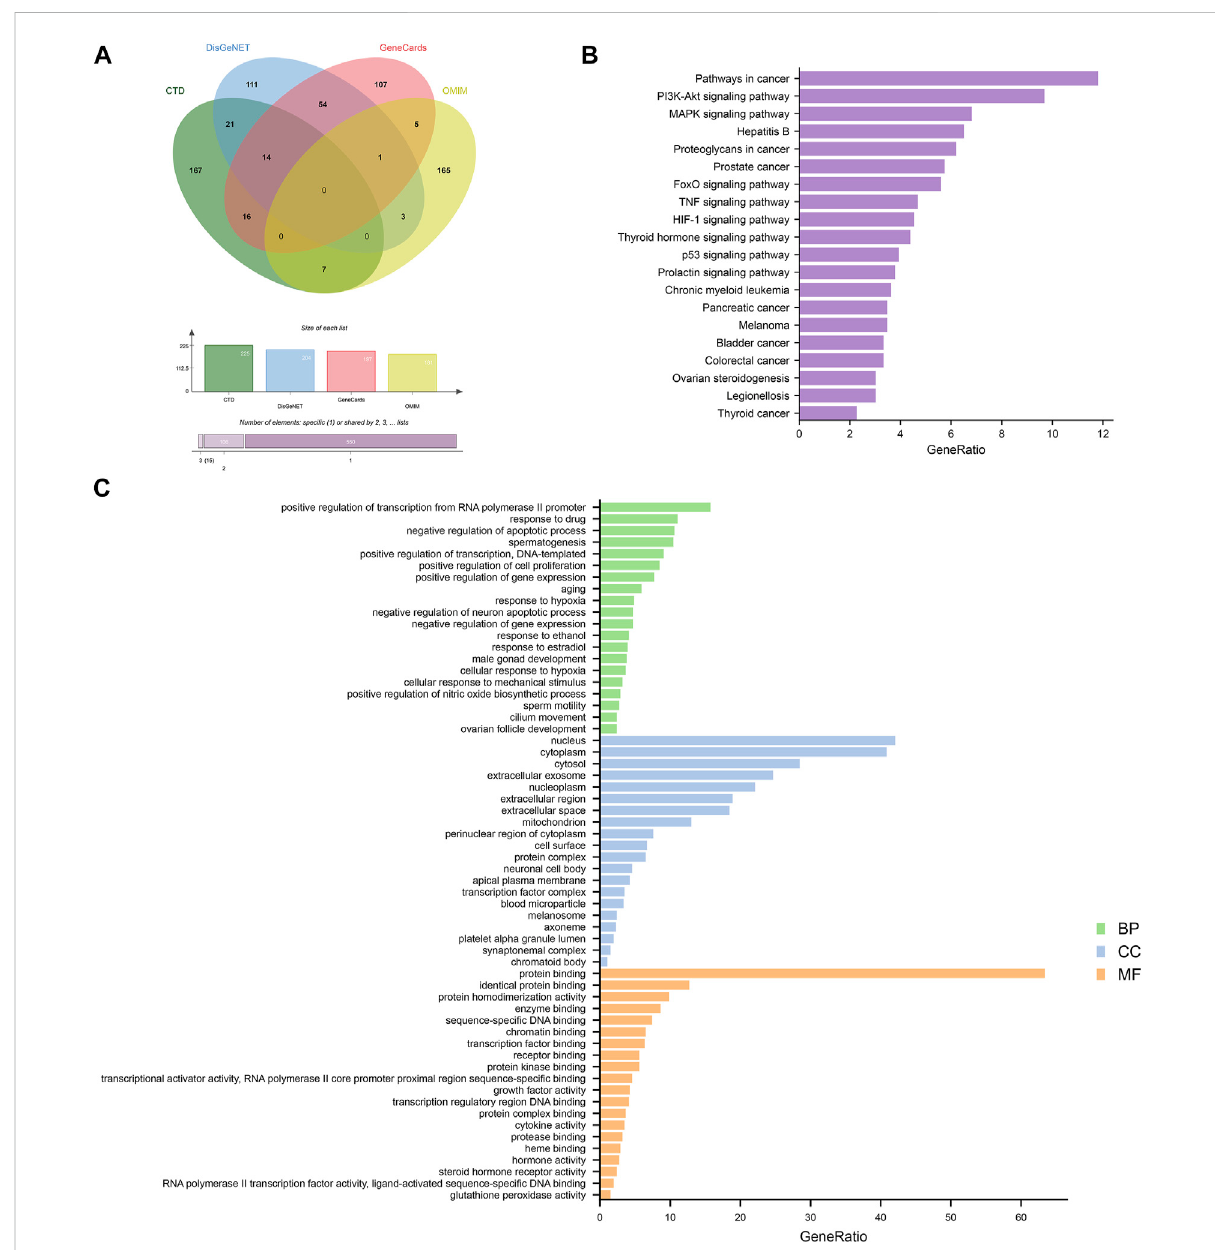
FIGURE 3 Analyses ofGO andKEGGenrichmentfor MI-relatedtargets ( p -value ≤ 0.05). (A) Venndiagram:thenumberofMI-relatedtargets fromthefour different databases are 225, 204, 197, and 181. (B) The top 20 KEGG pathways. (C) The top 20 GO enrichment terms include biological process, cellular component, and molecular function. The GeneRatio (%) of the top 20 most signi fi cant enrichments is shown in the bar